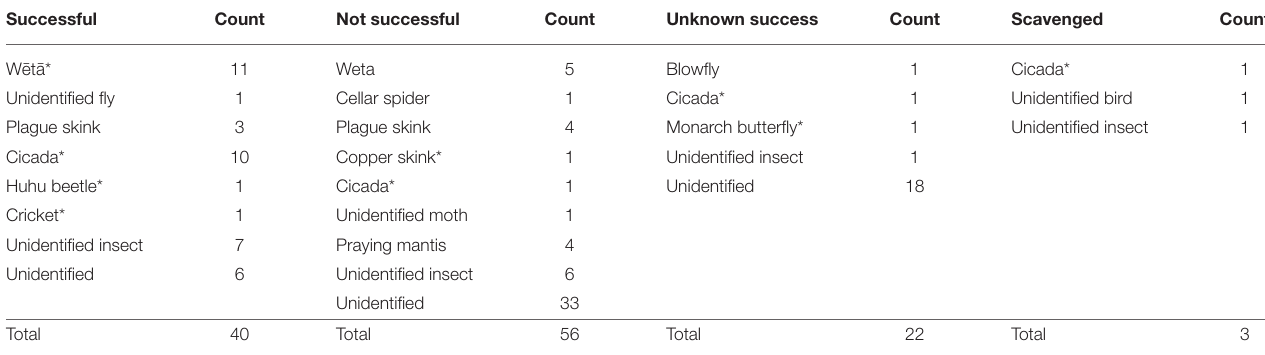
TABLE 5 | Predation event outcome by prey